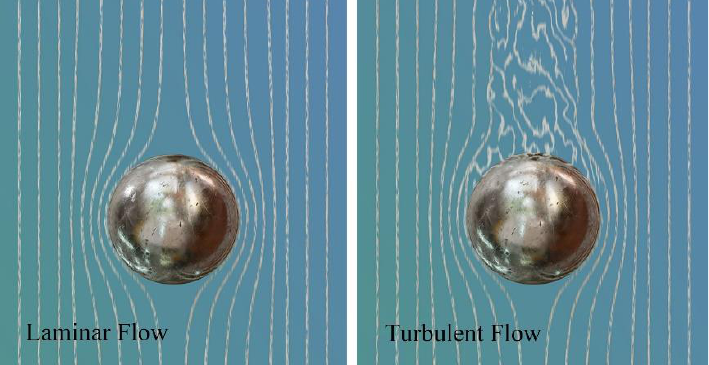
Figure 1. Schematic diagram for particles in the settling process.